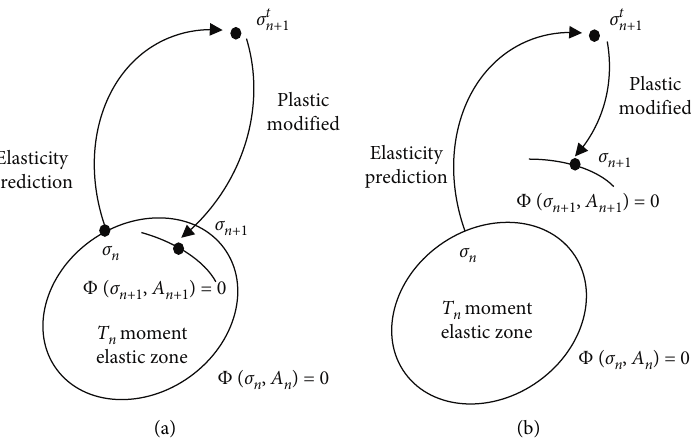
Figure 2: The general form of the return mapping algorithm. (a) Strain softening model. (b) Strain hardening